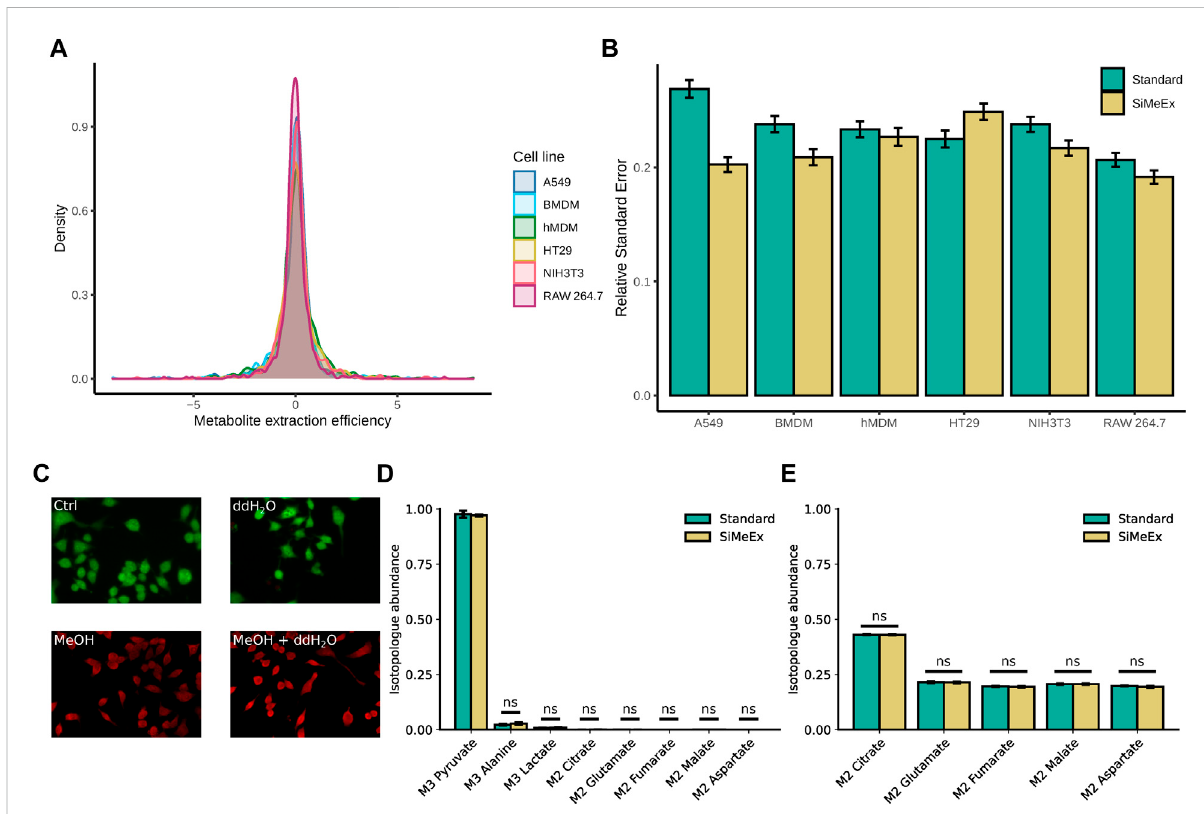
FIGURE 2 SiMeEx issuf fi cient tostopmetabolic activities anddisruptcellularandmitochondrialmembranes. (A) .Densityplotofthemetaboliteextraction ef fi ciency based on non-targeted GC-MS measurement. The metabolite extraction ef fi ciency is de fi ned as the log2-fold change of SiMeEx and the ‘ standard ’ method for the mean signals of each detected metabolite and biological replicate. (B) . Comparison of relative standard errors during the extraction with SiMeEx and the ‘ standard ’ method. Means and SEM are shown for each cell line, calculated based on the non-targeted measurement. (C) . Live/dead staining with calcein-AM (green, for esterase activity) and ethidium homodimer-1 (red, for DNA binding) of RAW 264.7 cells treated with 0.9% NaCl (Ctrl), ddH 2 O, MeOH or MeOH + ddH 2 O. (D) . Abundance of isotopologues of central carbon metabolites in disrupted RAW 264.7 cells incubated with [U- 13 C 3 ]-sodium pyruvate. Data is normalized to isotopologue abundance from unlabeled pyruvate control samples. (E) . Abundance of isotopologues of mitochondrial metabolites in RAW 264.7 cells incubated with [U- 13 C 6 ]-glucose, followed by ‘ standard ’ or SiMeEx extraction. (B,D,E) , data are presented as mean ± SEM pooled from three independent experiments with n = 6 – 12 (RAW264.7 cells) or 3 (all other cells) technical replicates